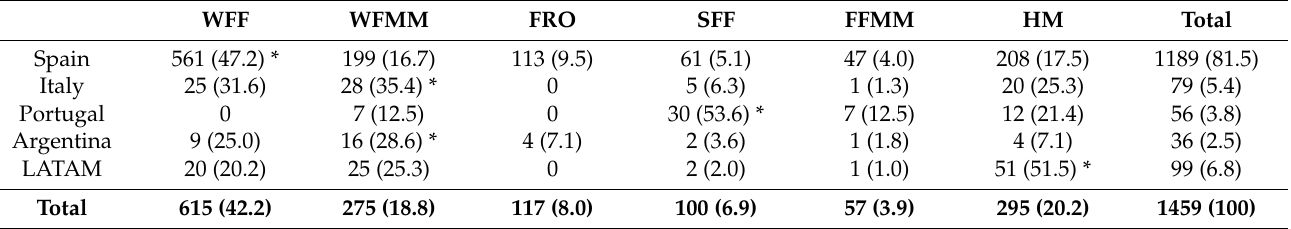
Table 1. Responses obtained by job position and country. Values expressed as absolute count